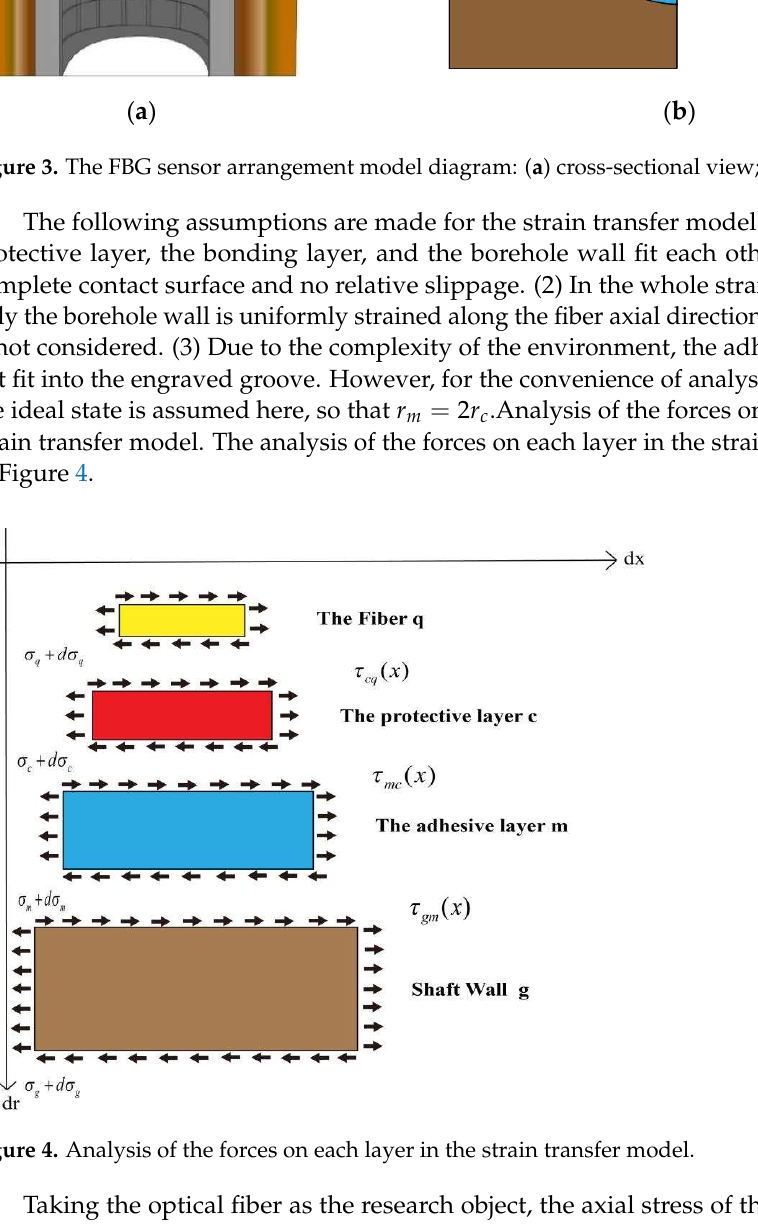
Figure 4. Analysis of the forces on each layer in the strain transfer model.